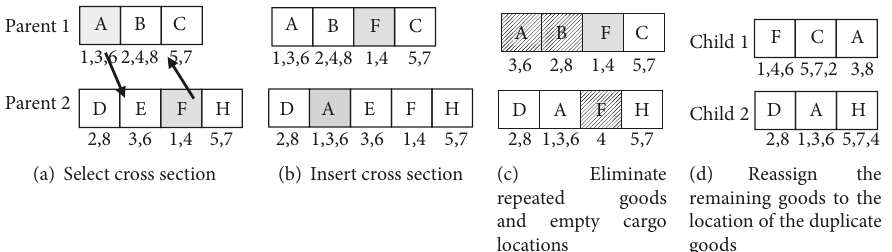
Figure 2: The crossover process.